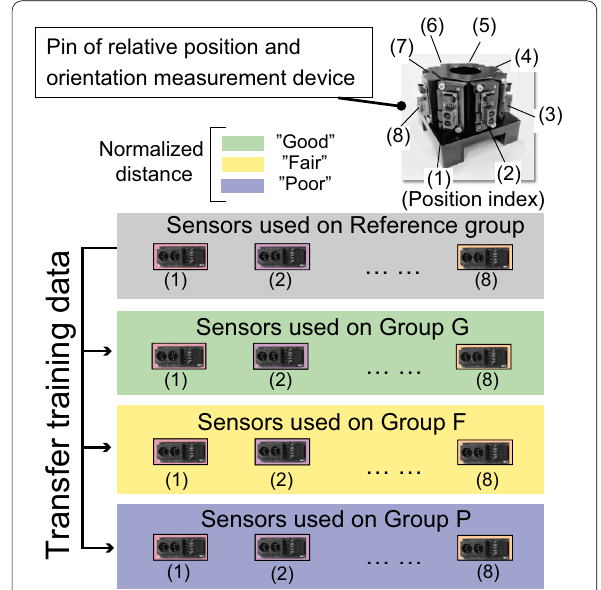
Fig. 11 Distribution of normalized distance of 132 sensors Fig. 12 Overview of experiment for deciding